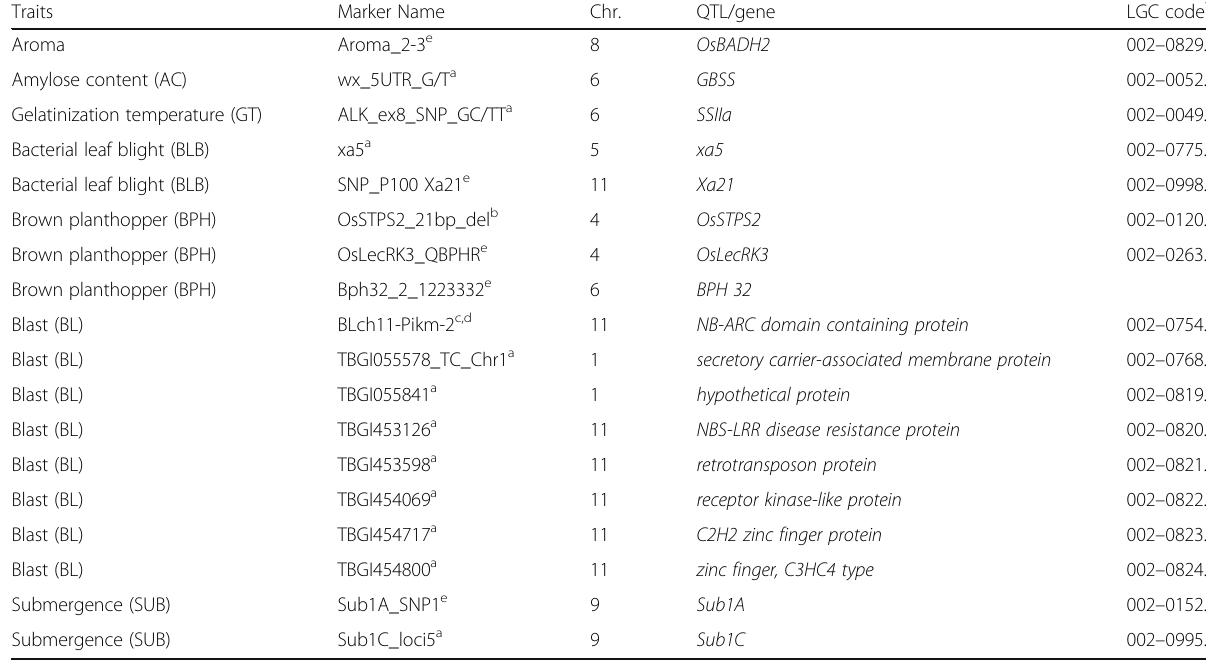
Table 1 KASP SNP markers for specific gene target used for MABC for improving KDML105